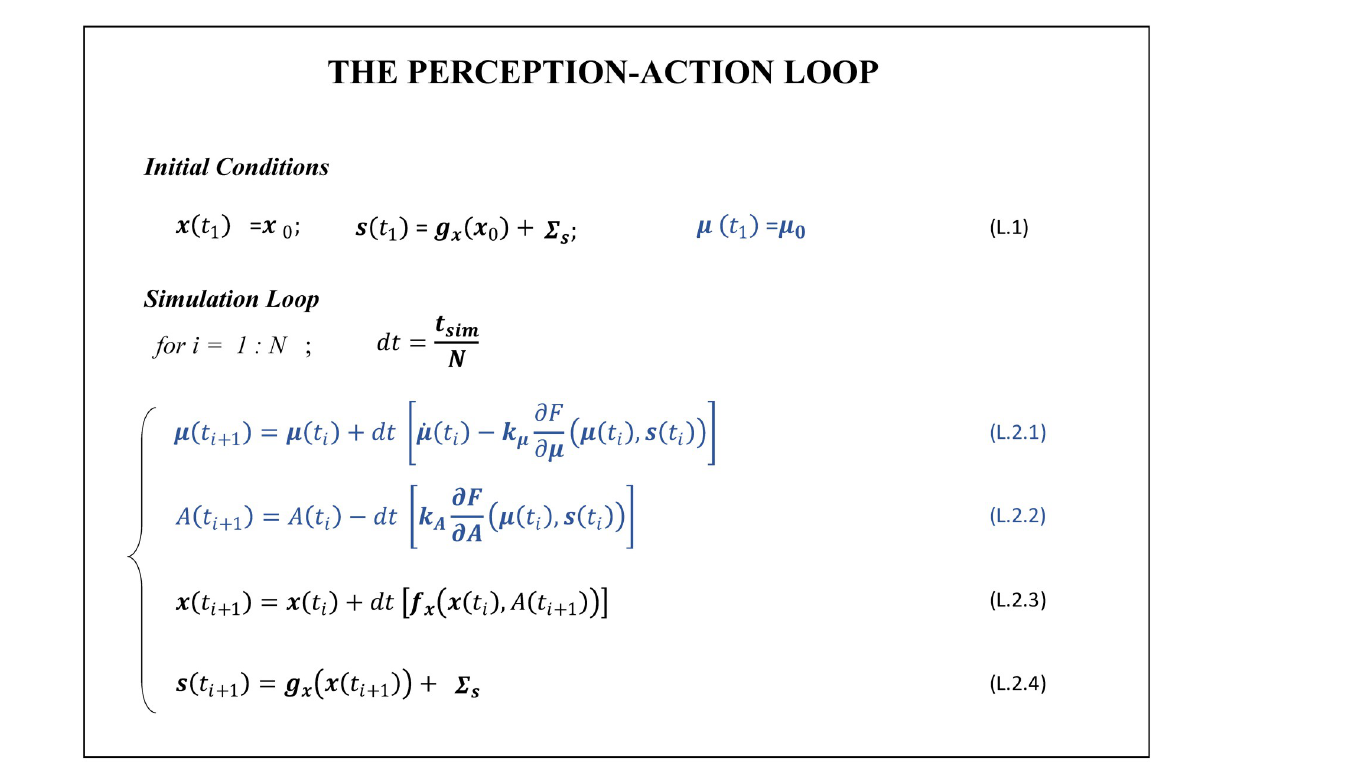
Fig 4. Perception-action loop of the active inference agent. The variables and equations in black (blue) are from the generative process (generative model), thus represent the real world (internal representations the agent holds about the system state and its dynamics). See the main text for a detailed explanation.